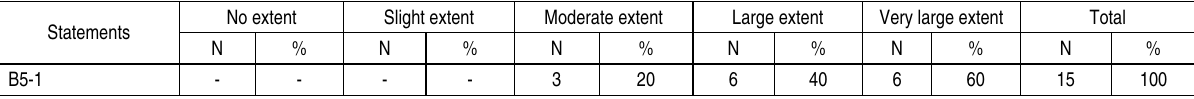
Table 4. Perception of the respondents on the statement regarding acquisition